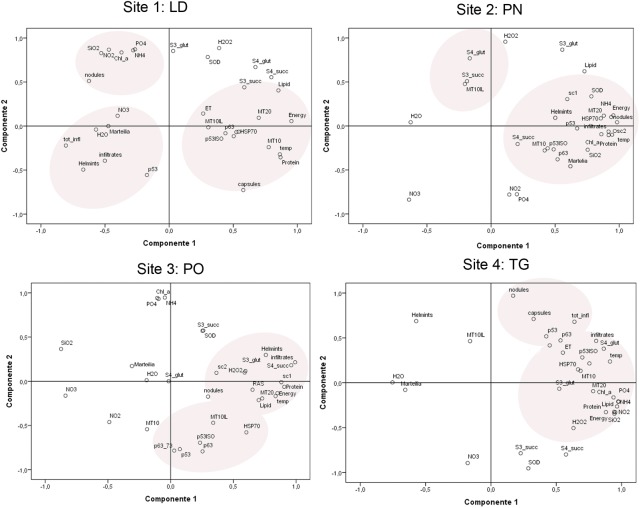
Principal component analysis and site groupings showing the relationship between mussel biomarker responses in the considered areas.